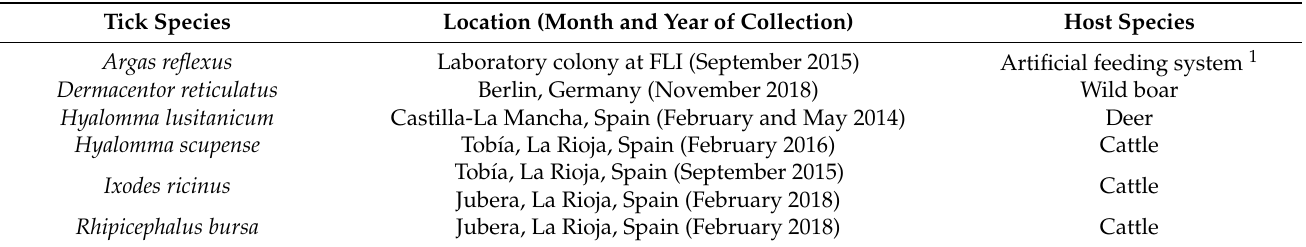
Table 1. Geographic origins, dates of collection and host species of engorged female ticks used to provide eggs for cell line